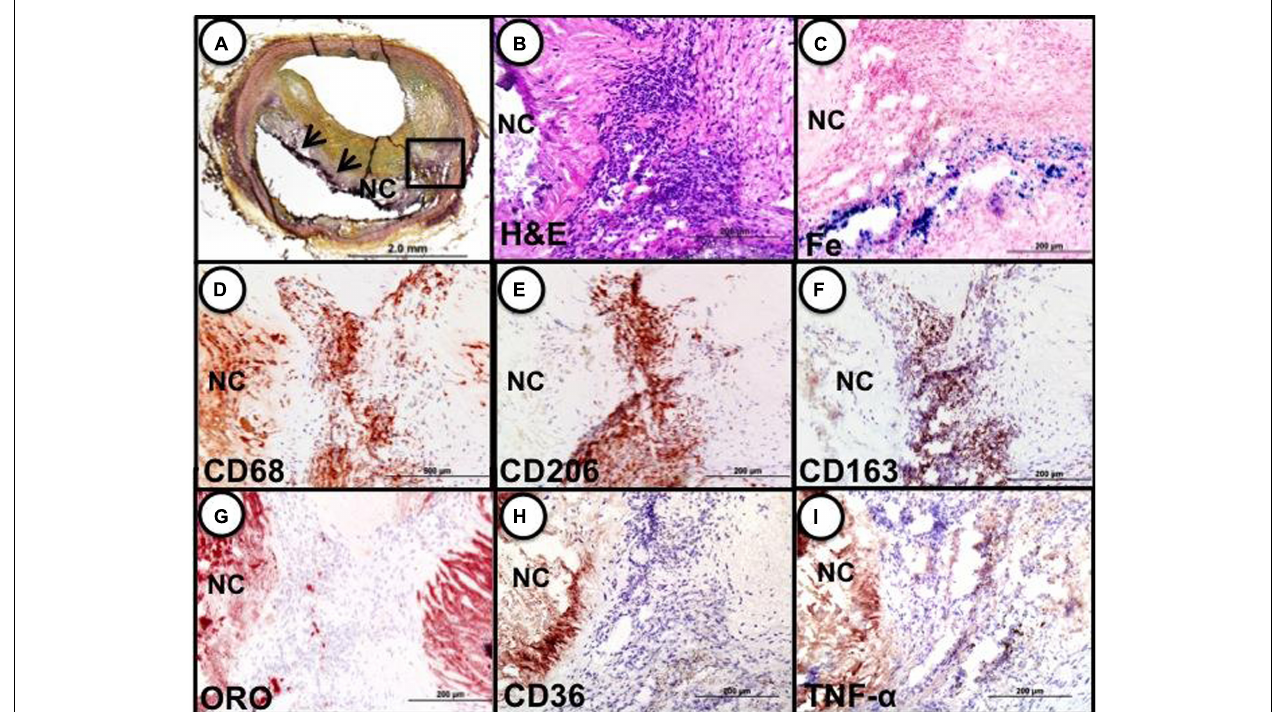
the mannose receptor (MR, CD206) within the cell cluster; note, however, the adjacent necrotic core shows negative staining. (F) The same